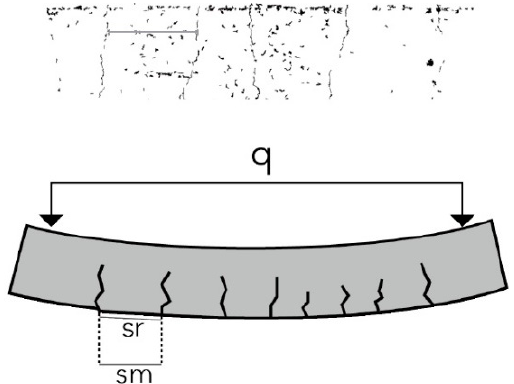
Figure 12. Measurement of crack spacing distance as a mean value in projection.